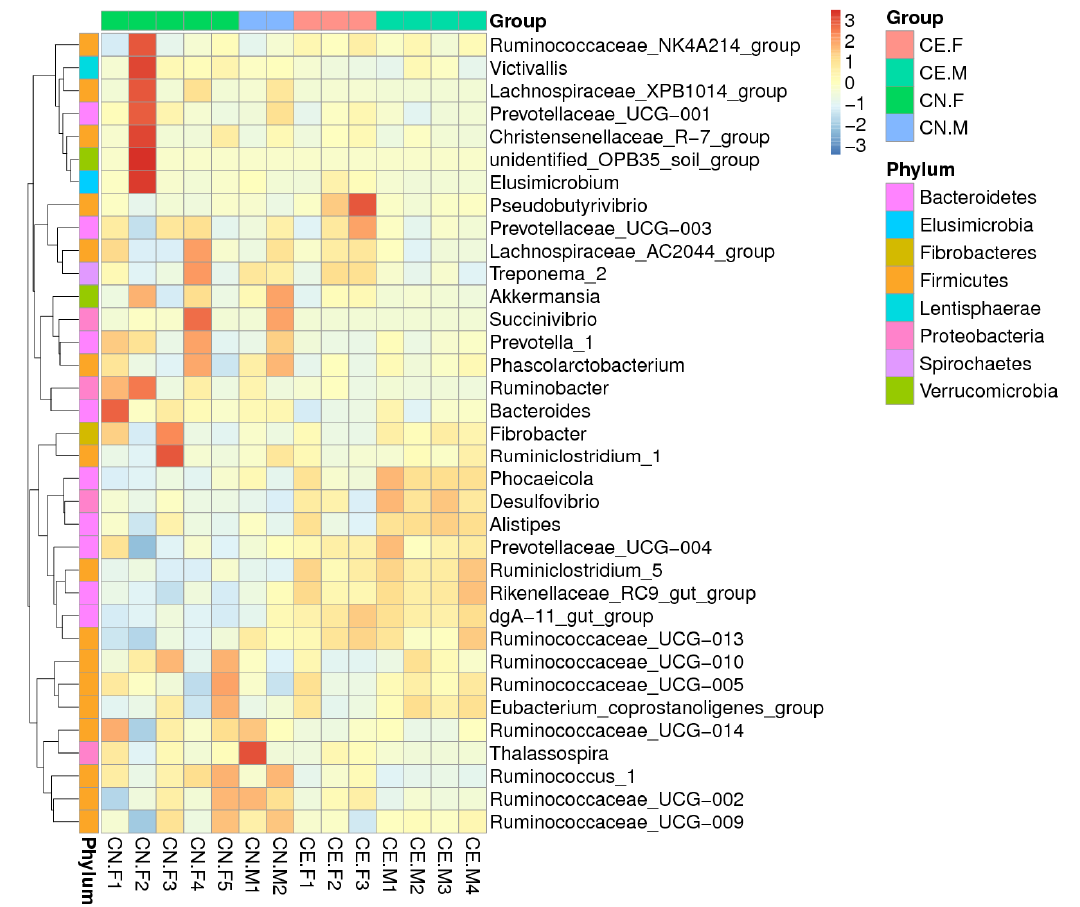
Figure 3. The heatmap of the clustering for species abundance. The information regarding the samples and species annotation is demonstrated along X-axis and Y-axis, respectively. The clustering tree was generated based on the relative abundance of the genera representing the top 35 most abundant bacteria at the species level. The relative values in the heatmap depicted by colors, after normalization, indicate the aggregation degree or content of bacterial species among samples at the genus level. UPMGA clustering trees.